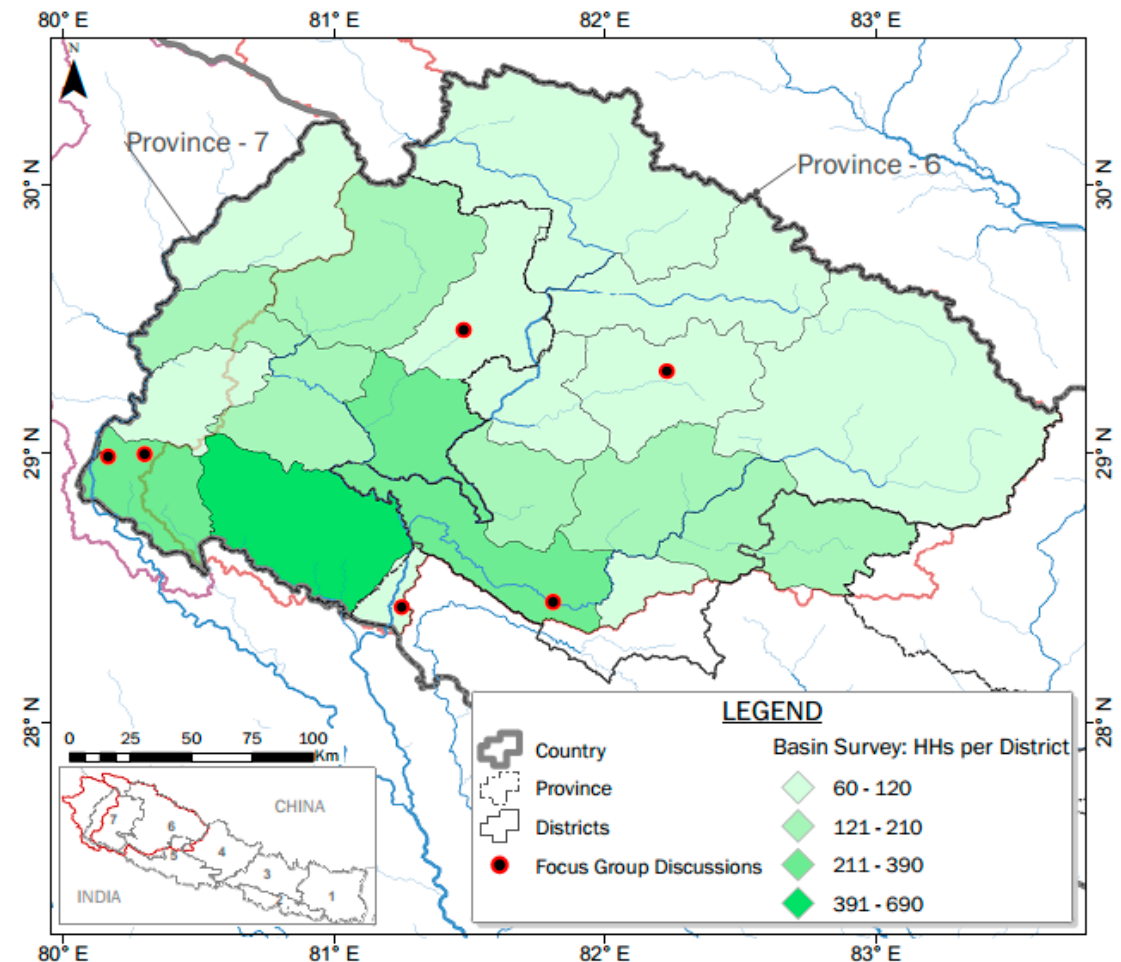
Figure 3. Spatial distribution of 3660 survey households across districts in Western Nepal based on stratification along 21 strata.